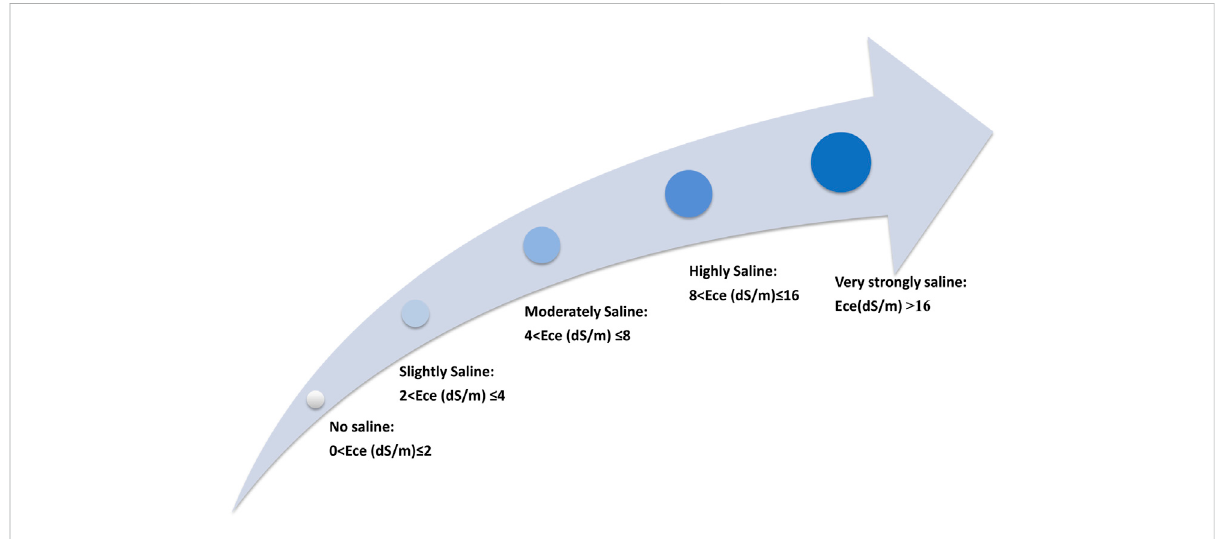
FIGURE 1 Soil salinization classi fi cation standards (Lech et al.,